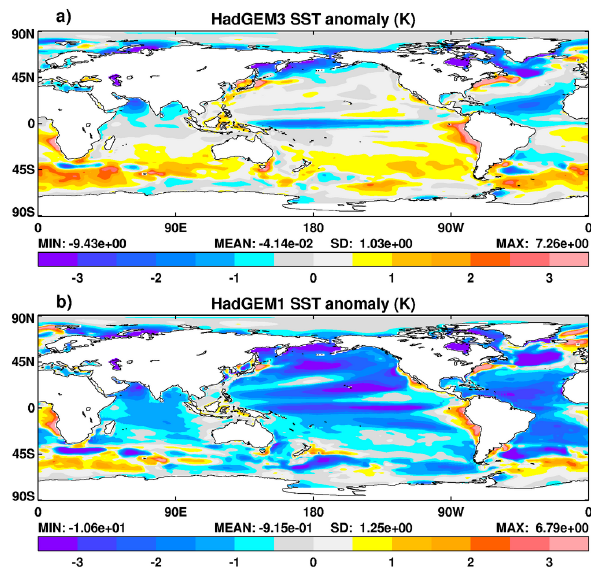
Figure 11: Sea surface temperature (K) anomalies with respect to initial conditions for (a) (cid:5)(cid:2) Fig. 11. Sea surface temperature (K) anomalies with respect to ini- HadGEM1 and (b) HadGEM3 r1.1 (cid:6)(cid:2) tial conditions for (a) HadGEM1 and (b) HadGEM3 (cid:7)(cid:2)